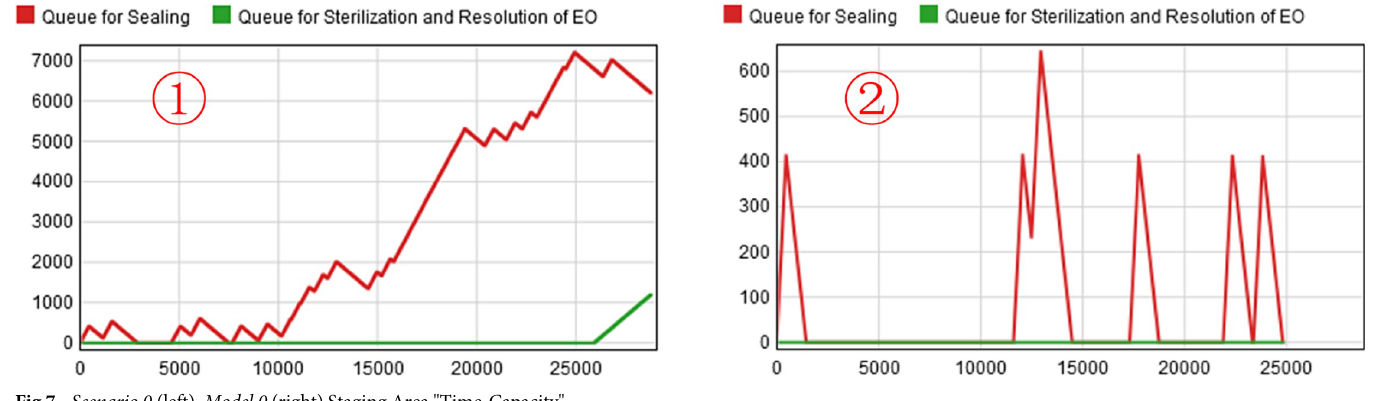
Fig 7. Scenario 0 (left), Model 0 (right) Staging Area